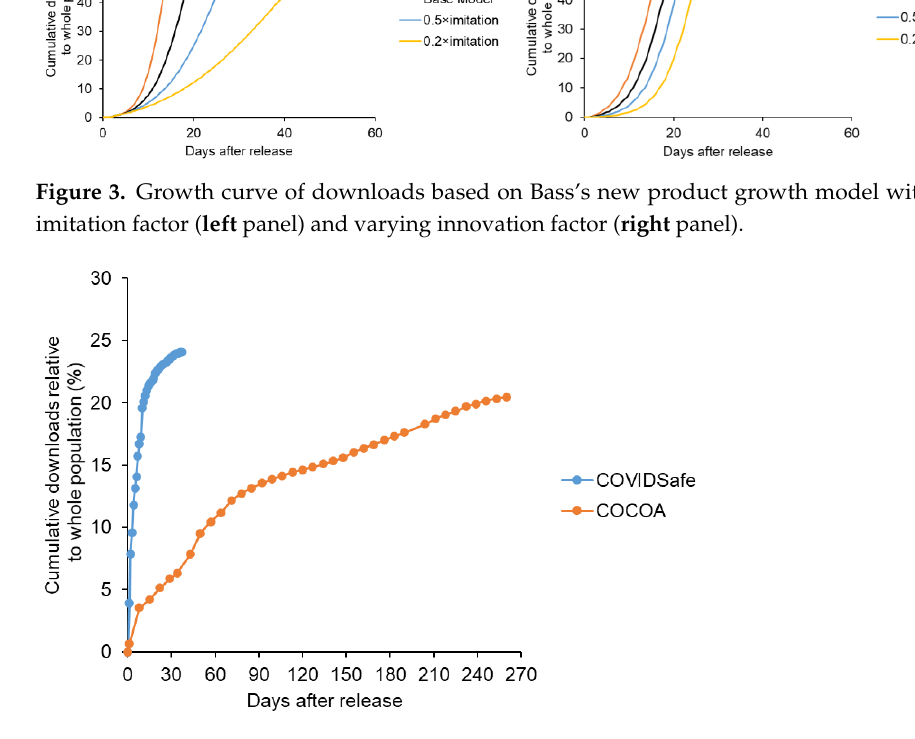
Figure 4. Confirmed downloads of COVIDSafe and COCOA apps after release.